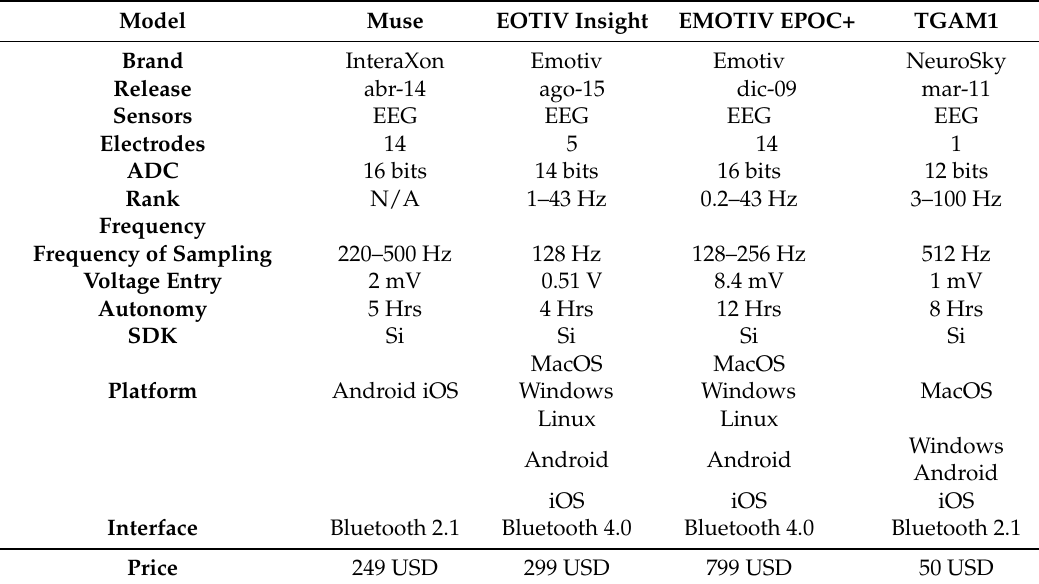
Figure 1. Electroencephalographic devices. Table 1. Comparison of electroencephalographic